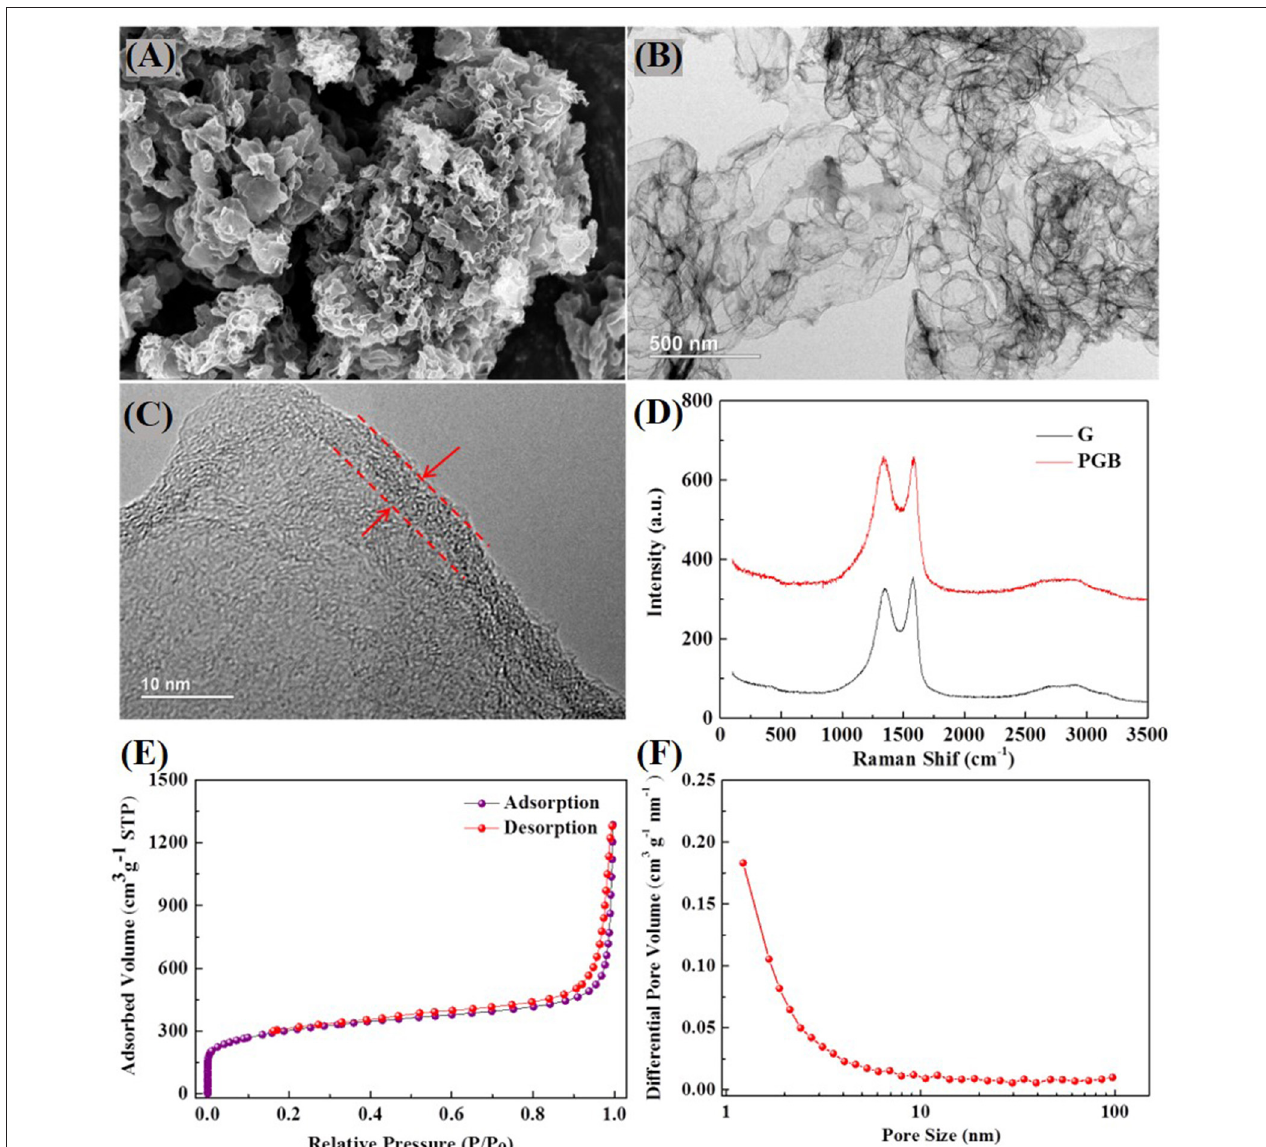
FIGURE 2 | (A) SEM, (B) TEM, and (C) HRTEM images of the synthesized PGBs; (D) Raman spectra of PGBs and obtained graphene powder, (E) nitrogen adsorption–desorption isotherms, and (F) pore size distribution of